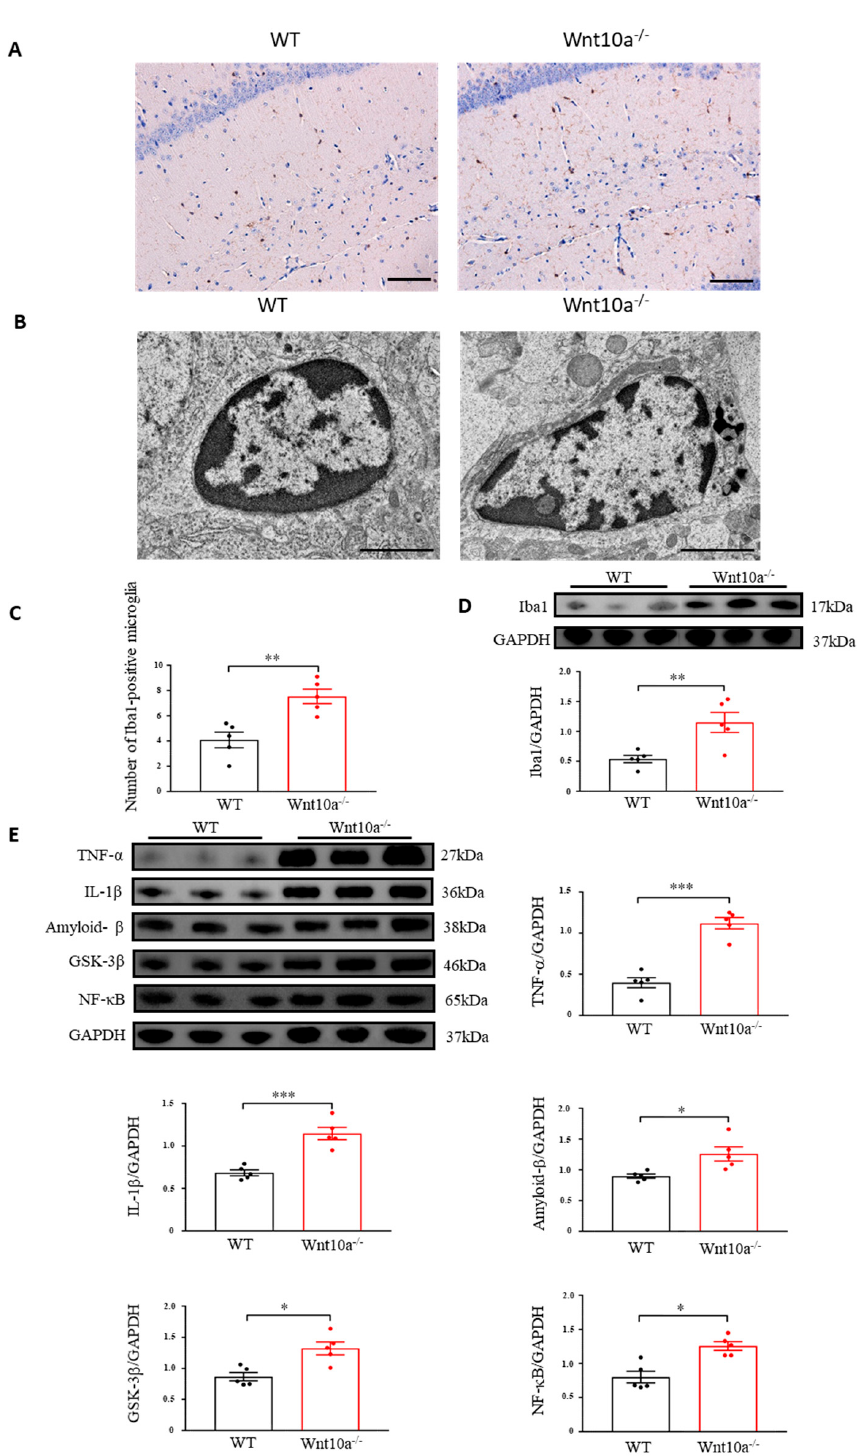
Figure 6. Immunostaining and electron microscopic images of microglia and the protein expression of neuroinflammatory mediators in the hippocampus. Hippocampal Iba1-positve microglia was significantly increased ( A , C ). Lysosomes were abundant in the hippocampal microglia of Wnt10a -/- mice ( B ). Scale bars = 100 µ m in ( A ) and 2 µ m in ( B ). The protein expression of Iba1 was significantly higher in the hippocampi of Wnt10a -/- mice ( D ). The protein expressions of hippocampal amyloid- β , NF- κ B, GSK-3 β , TNF- α , and IL-1 β were significantly higher in Wnt10a -/- mice than in WT mice ( E ). Data are expressed as mean ± SEM; n = 5/group; * p < 0.05, ** p < 0.01, and *** p < 0.001.